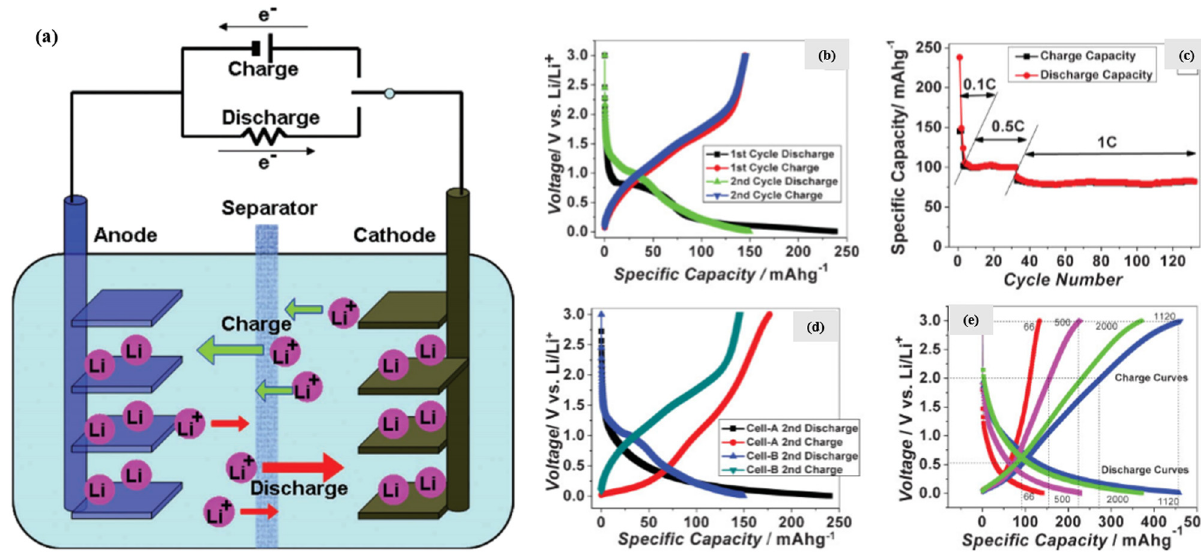
Figure 7: ( a ) Mechanism diagram of VACNTs as electrode materials for Li - ion batteries [ 51 ] . Copyright 2016, Wiley. ( b ) First two cycles of charge – discharge plots of cell at 0.1 C. ( c ) Cycling stability of cell at di ff erent rates. ( d ) Comparison of the second - cycle voltage – capacity plots of a di ff erent cell. ( e ) Voltage – capacity plots of cell at di ff erent cycles [ 52 ] . Copyright 2019,